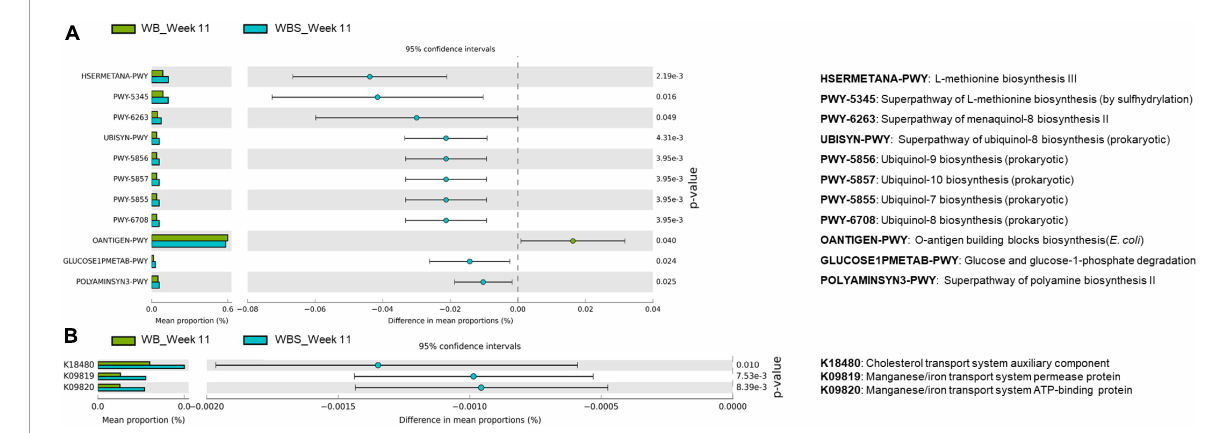
FIGURE7 Predicted functional profiling analysis of WB and WBS groups at week 11 using PICRUSt2. (A) Prediction pathways and (B) functional orthologs using the KEGG database are illustrated on the extended error bar plot. WB: mouse feeding group with yeast-fermented white bread, WBS: mouse feeding group with 40% sourdough-supplemented white